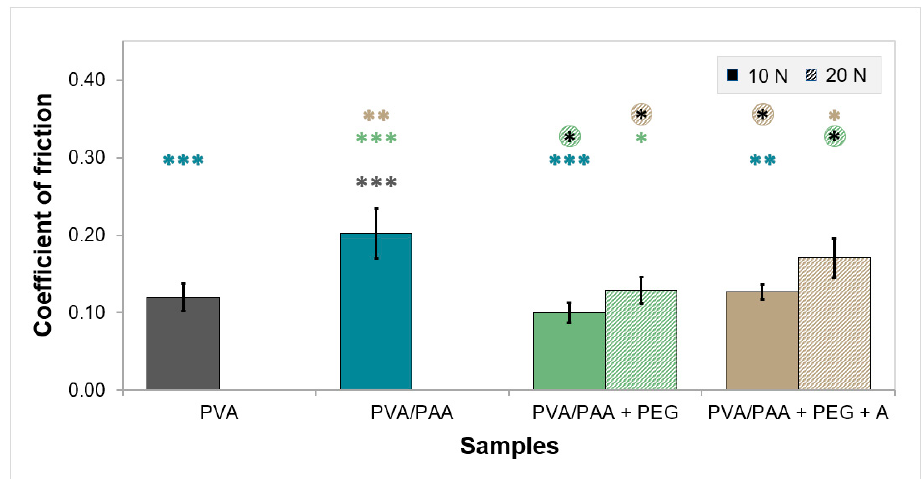
Figure 6. Friction coefficients of the samples tested against SS 316L in PBS solution under a load of 10 or 20 N. Error bars are the ± standard deviations, n = 3. Pairwise comparisons involving at least one group assayed at 20 N were done using the independent samples t-test. All other comparations were performed using ANOVA ( p < 0.0005) and Tukey’s HSD test and refer to comparisons with results obtained with load 10 N and 20 N, respectively. Statistical differences are indicated by asterisks (* p < 0.05, ** p < 0.005, *** p < 0.0005).